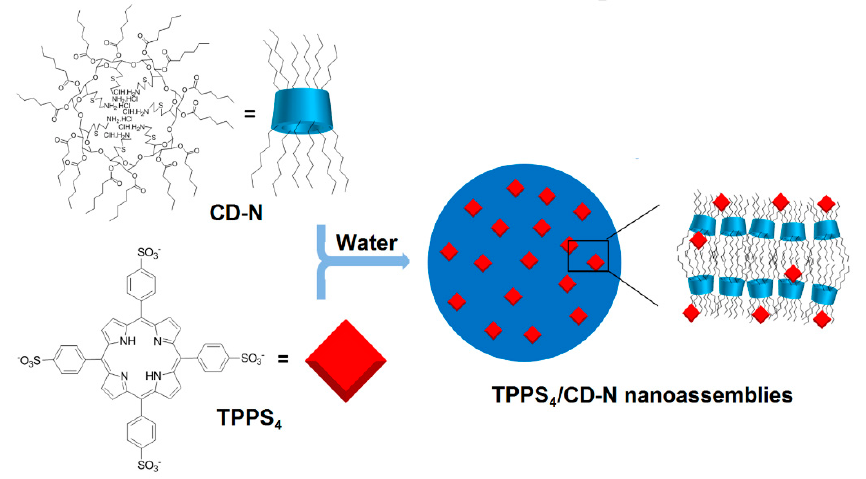
Figure 42. Molecular structure of cyclomaltoheptaose (CD-N), TPPS 4 and corresponding TPPS 44 /CD-N nanoassembly. Adapted from Mazzaglia; Micali; Villari; Zagami; Pennisi; Mellet; Fernandez; Sciortino; Scolaro [168].